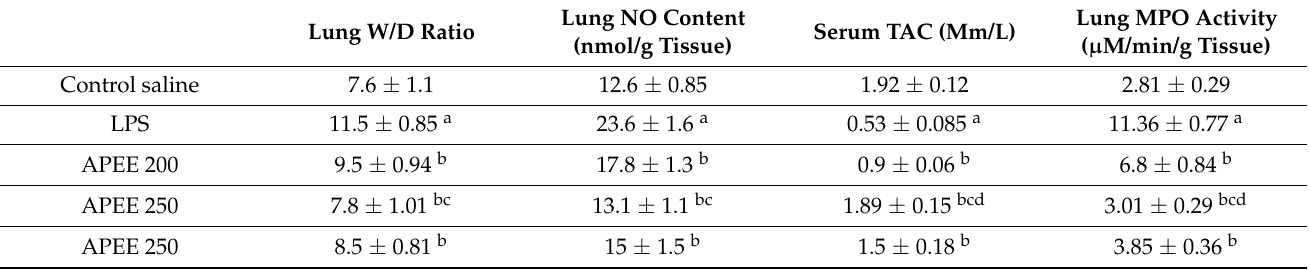
Table 3. Effects of APEE Pre-treatment on lung W/D ratio, lung NO, Serum TAC, and MPO activity in LPS-induced acute lung injury in